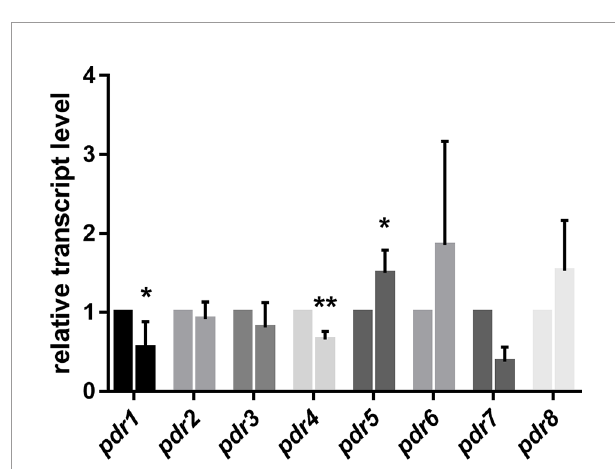
FIGURE 4 | Relative transcript levels of pdr genes under anaerobic condition. Transcript level of each gene was measured under aerobic condition was taken as 1. The presented values are averages of three independent experiments; error bars indicate standard deviation. For RNA extraction, fungal strains were cultivated on YNB for two days at 25°C. Relative transcript values followed by * and ** signi fi cantly differed from the value taken as 1 according to the paired t-test (* p < 0.05 and ** p <